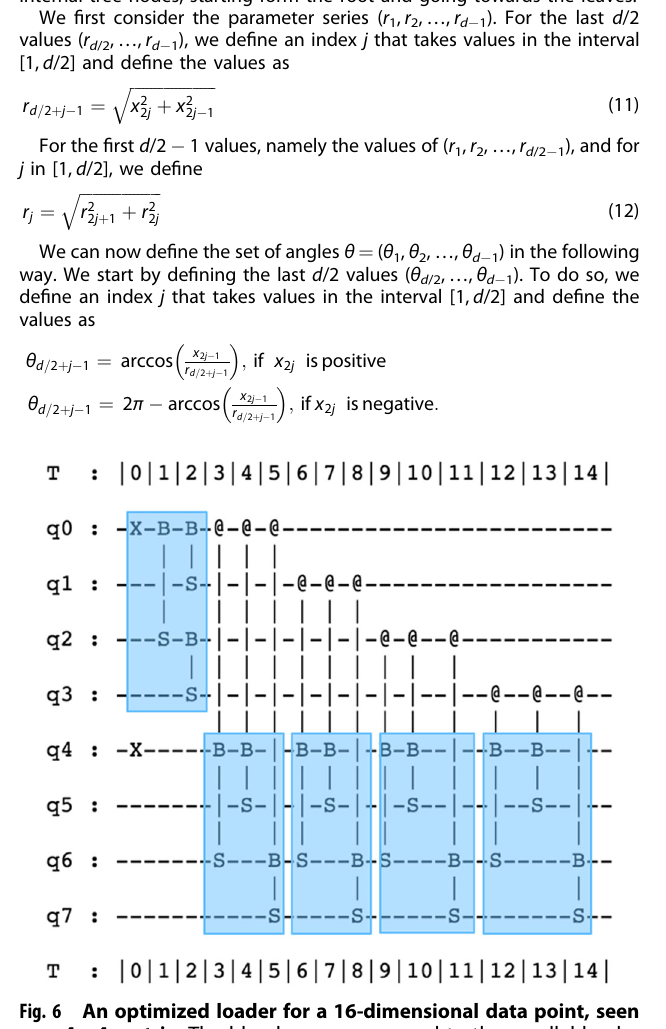
Fig. 6 An optimized loader for a 16-dimensional data point, seen as a 4 × 4 matrix. The blue boxes correspond to the parallel loader from Fig. 1 and its controlled versions.